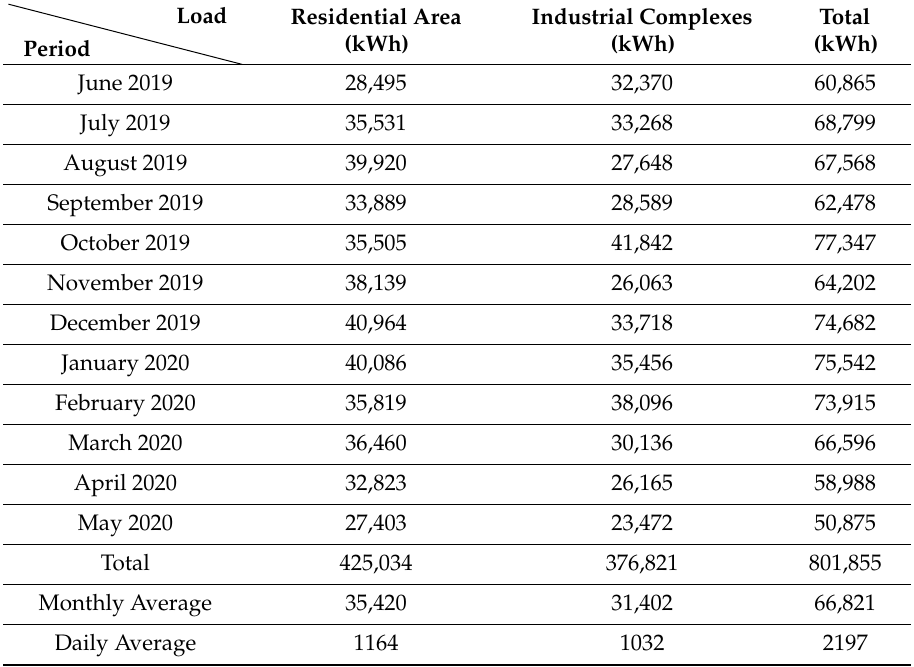
Table 1. Monthly power consumption of the target